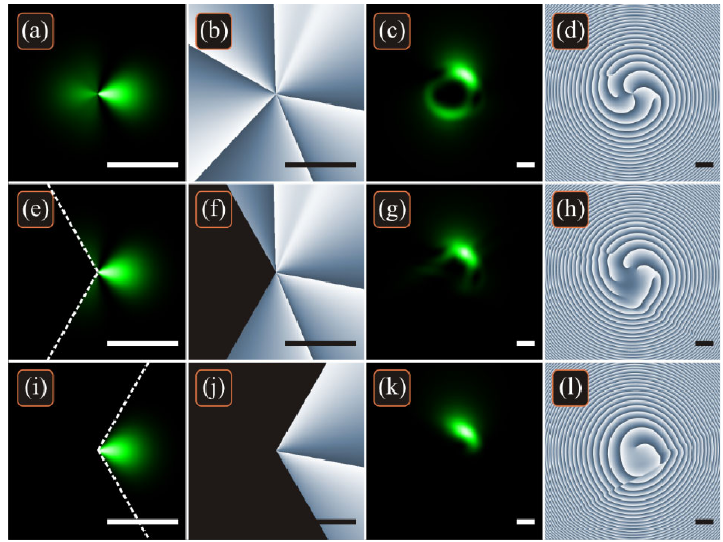
Figure 2. Intensity (columns 1 and 3) and phase (columns 2 and 4) distributions of the beam (1) in the initial plane (columns 1 and 2) and at the Rayleigh distance from it (columns 3 and 4), when the beam (1) is not truncated ( a ‐ d ) or truncated by two different sector apertures ( e ‐ l ).